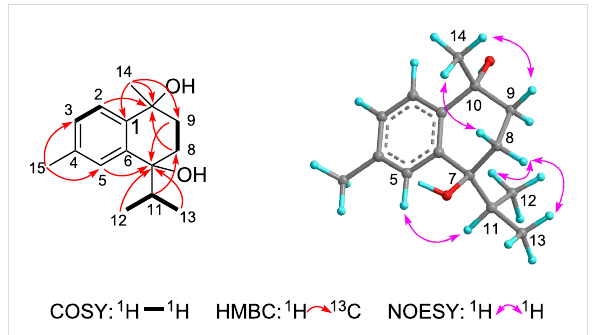
Figure 4: 1 H- 1 H COSY, key HMBC correlations, and NOESY correla- tions of compound 5